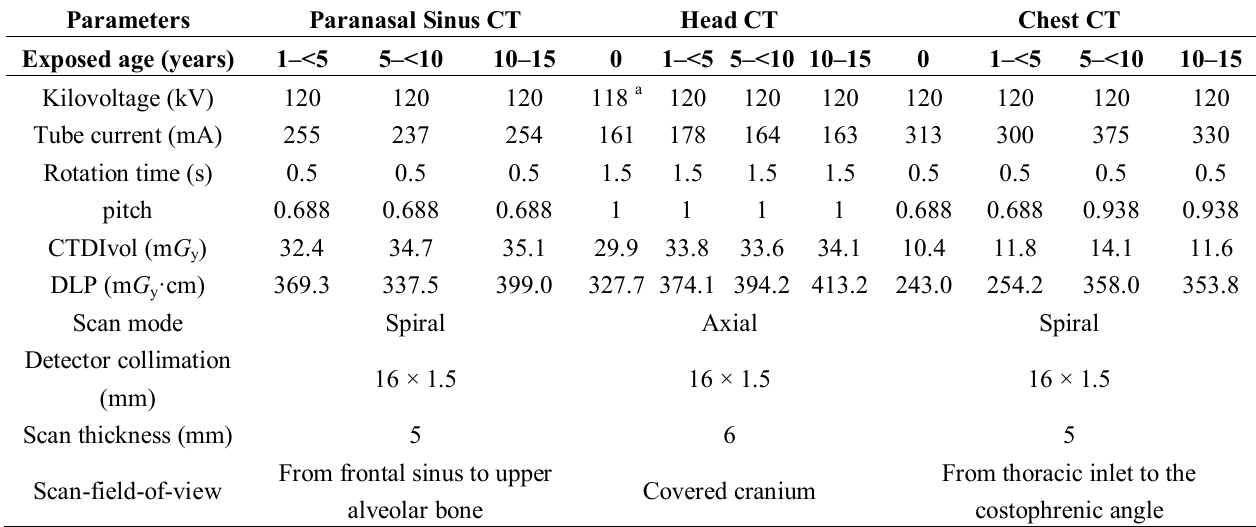
Table 3. Parameters used by three CT protocols considered in this